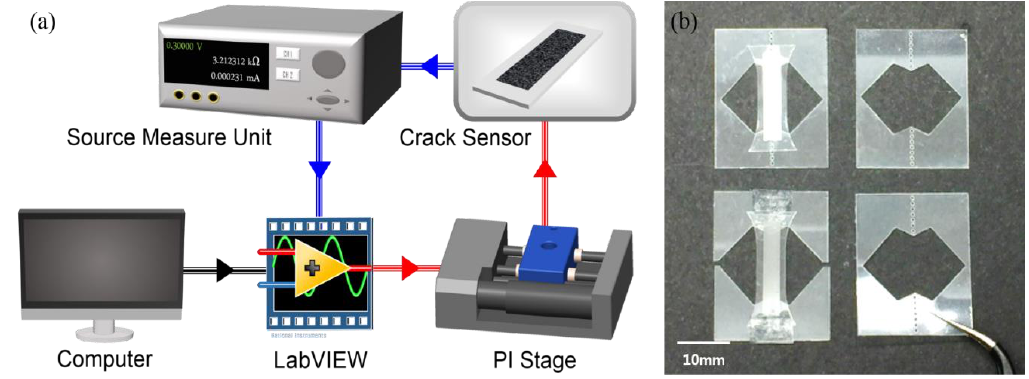
Figure 2. ( a ) Schematic of the sensor measurement system and ( b ) sensor